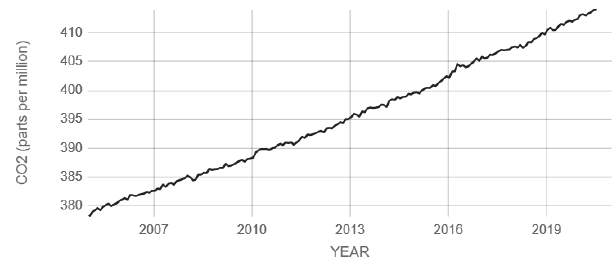
Fig. 1. Direct measurement: 2005-present